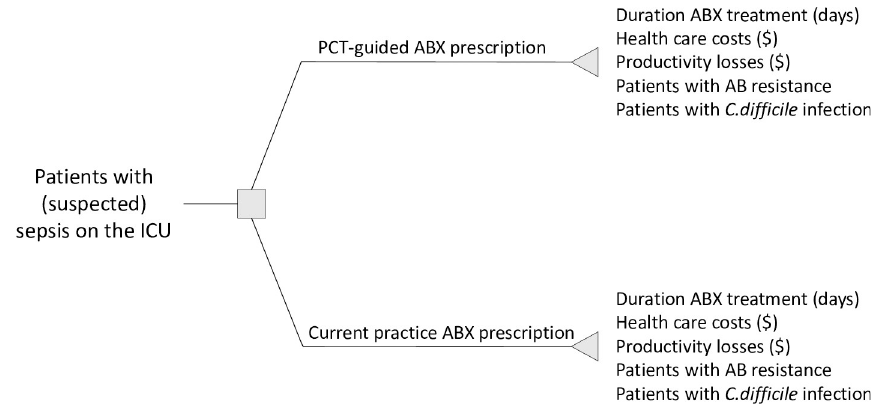
Fig 1. Decision-tree for patients with sepsis. ABX = Antibiotics.